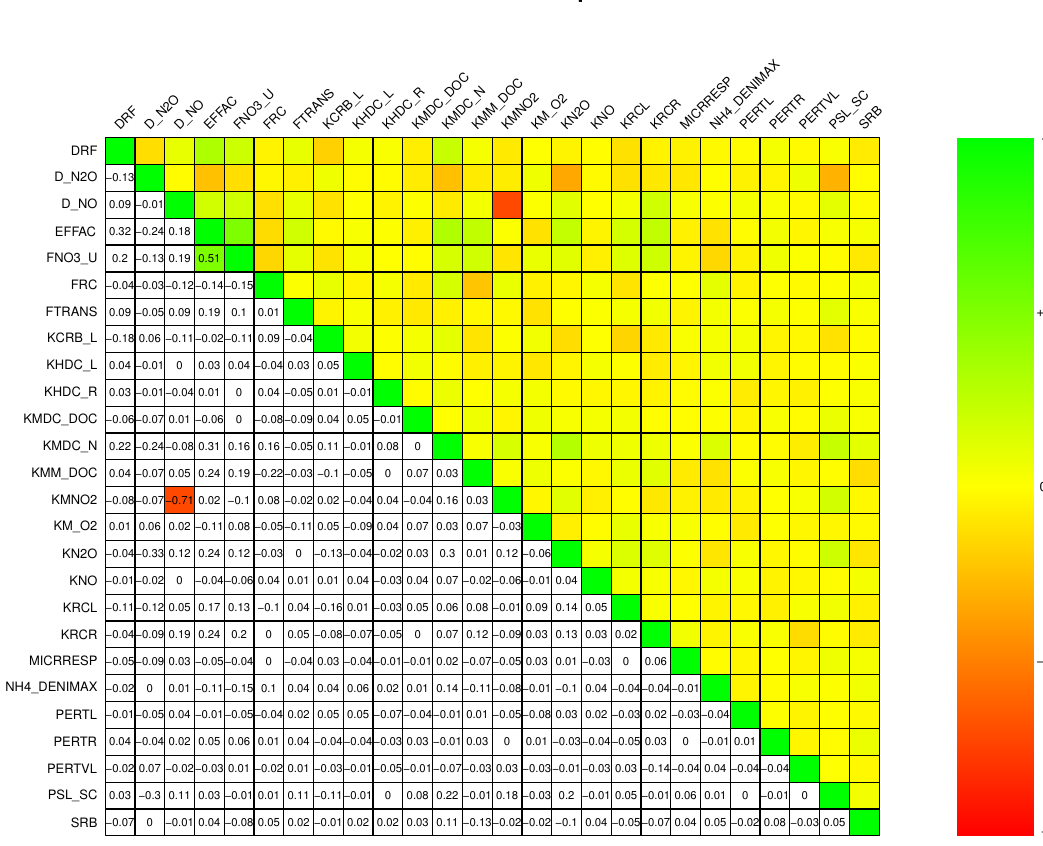
Fig. 8. Correlations of all post burn-in parameter samples.